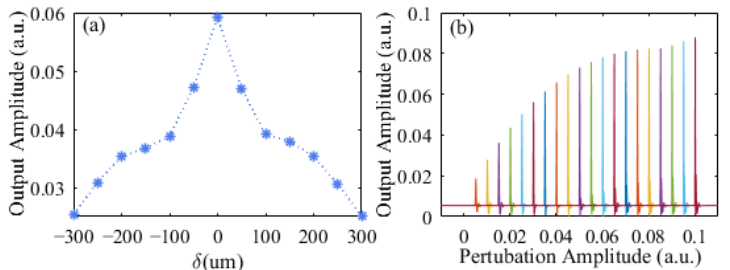
Figure 4. The frequency region of spiking dynamics ( a ); The quasi-threshold behavior of the proposed MRR-based neuron ( b ). The output spike is presented in the order in which the perturbation power increases.